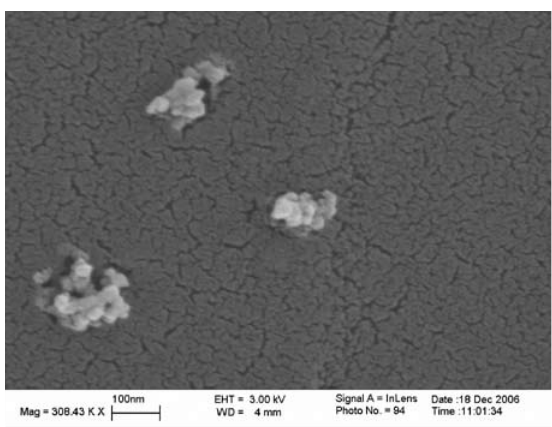
Fig. 4 SEM image of based TiO 2 nanofluids: Degussa P25 TiO 2 with primary particle diameter 〜